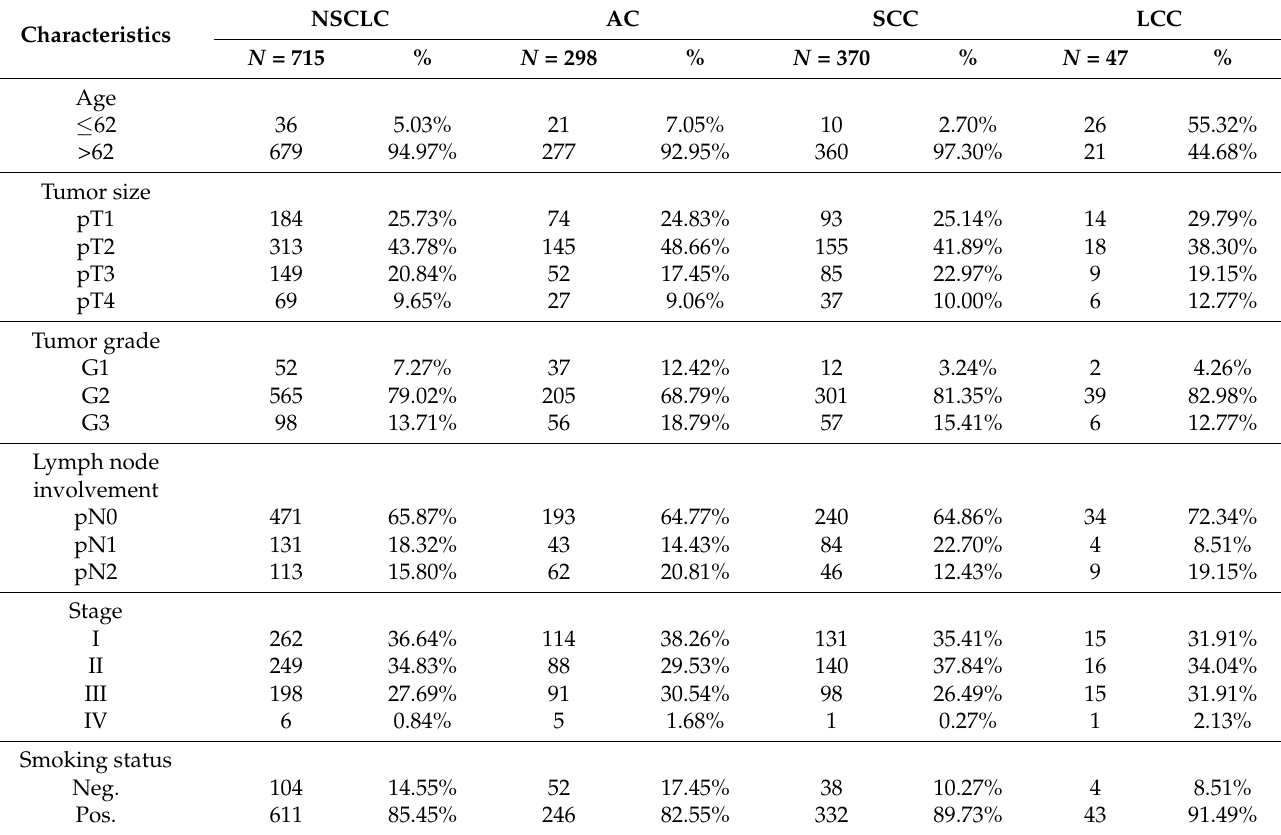
Table 2. Clinical and pathological characteristics of patients with non-small cell lung carcinoma